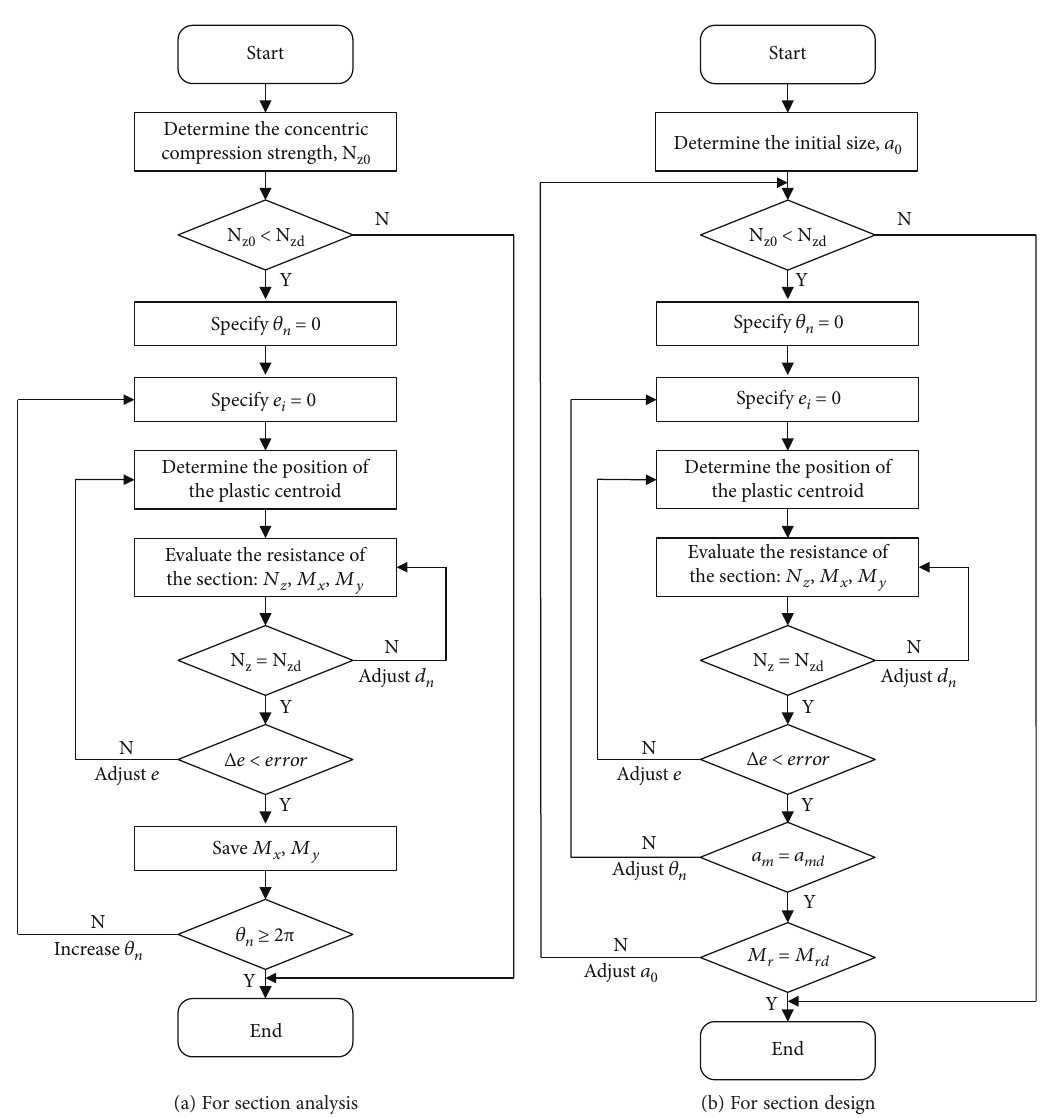
Figure 2: Flowcharts for section analysis and design of composite columns under biaxial